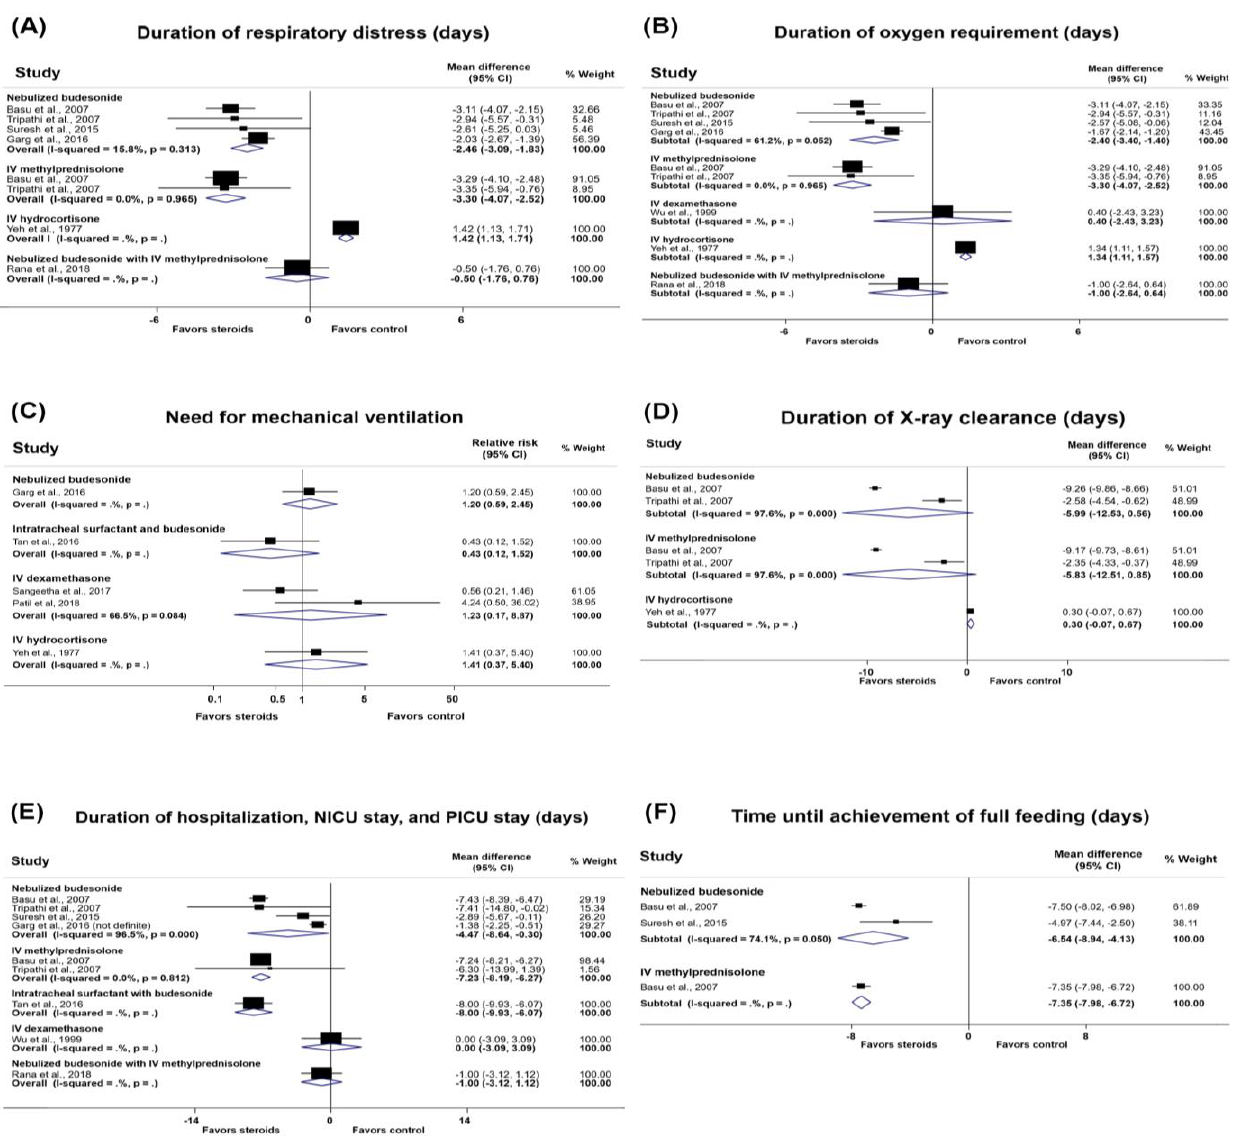
Figure 2. Forest plots of the effects of steroids in infants with meconium aspiration syndrome. ( A ) Duration of respiratory distress; ( B ) duration of oxygen requirement; ( C ) need for mechanical ventilation; ( D ) duration of X-ray clearance; ( E ) duration of hospitalization, NICU stay, and PICU stay; ( F ) time until achievement of full feeding.